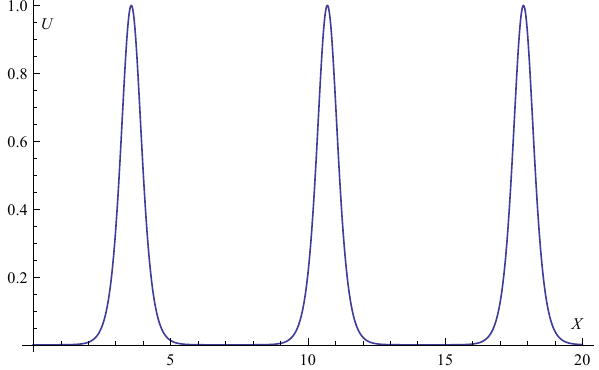
Fig. 7. Solution of the Ginzburg–Landau equation.